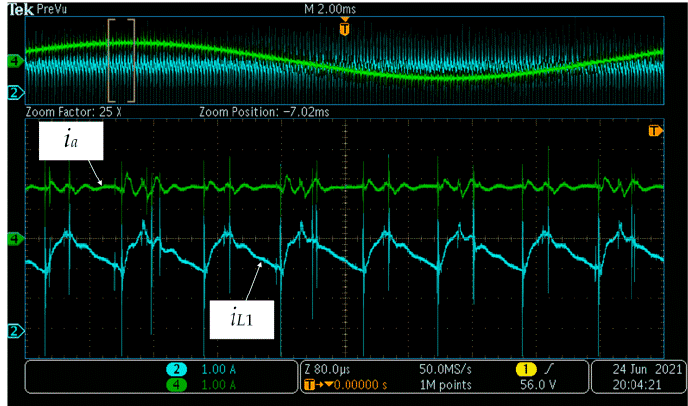
Figure 16. Waveforms of the modified zero-sync method of the STS injection where 0 < D 0 < D 0, max